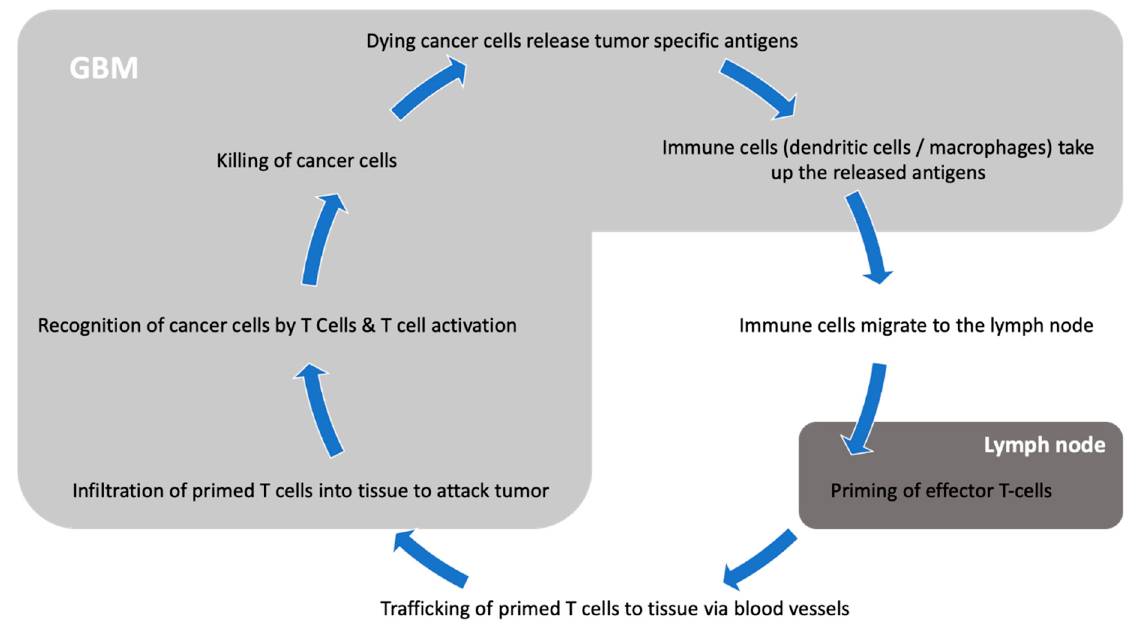
Figure 1. Interaction between GBM and the immune system.